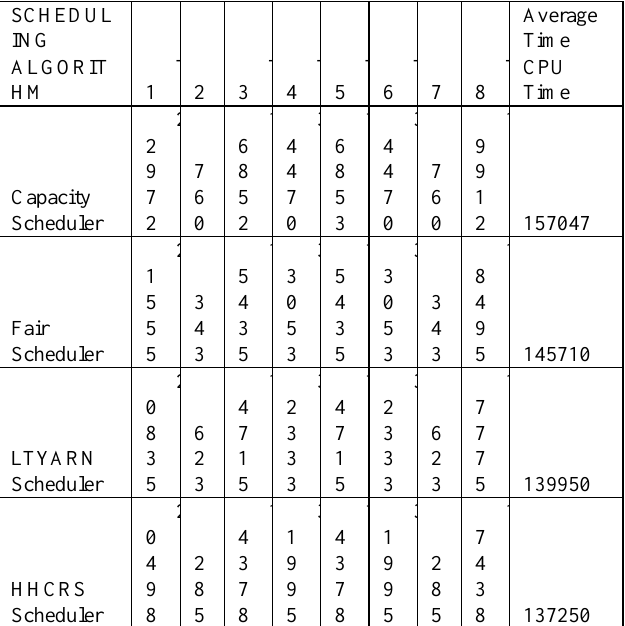
Table 5: Performance Measure - CPU Utilization